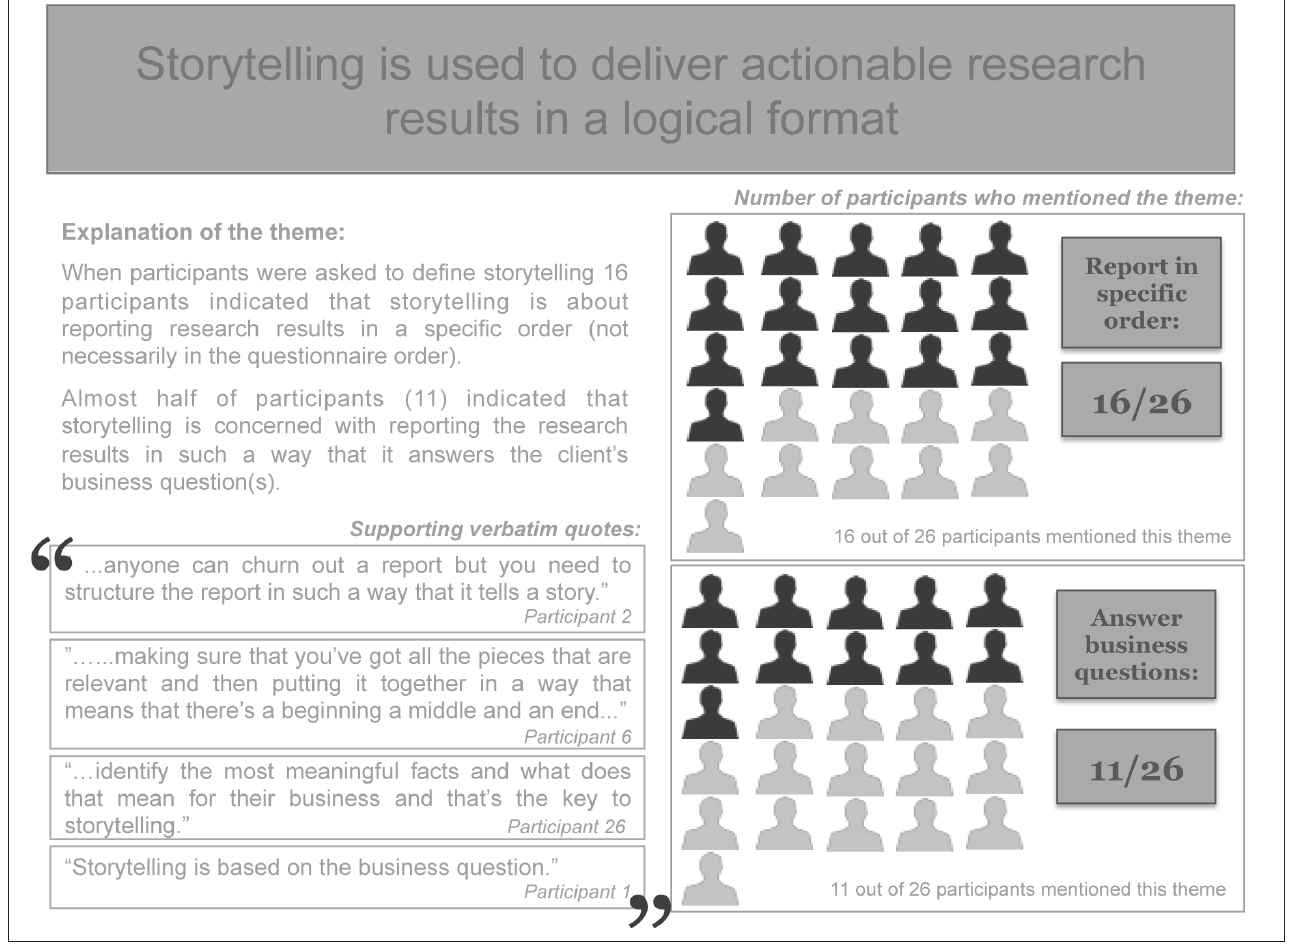
FIGURE 2: The use of